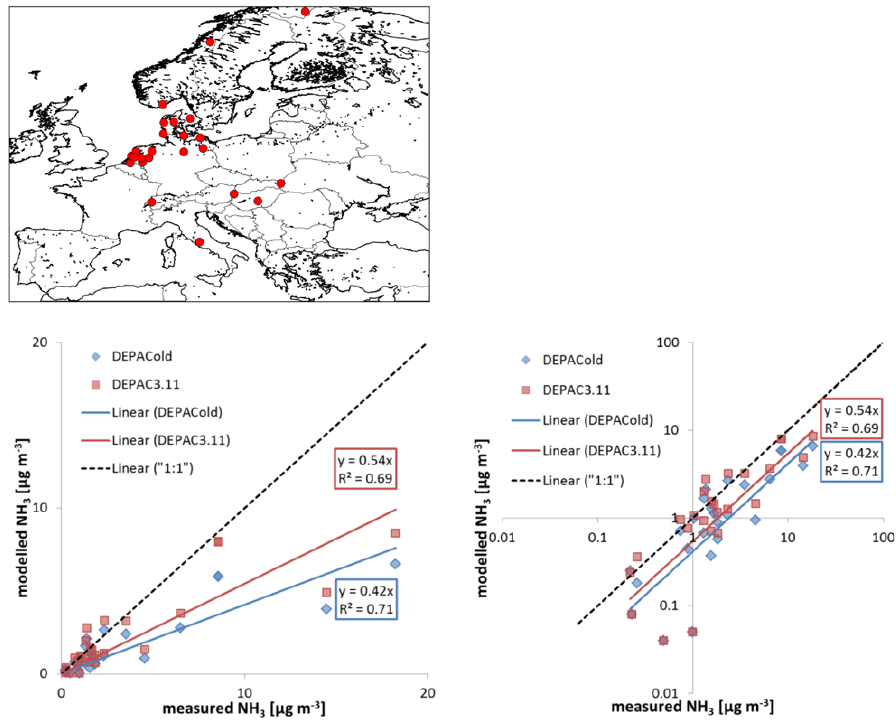
Fig. 7. Comparison of the modeled ammonia concentrations (with DEPACold and DEPAC3.11) with the measured concentrations at the available EMEP stations in Europe and the NAQMN in the Netherlands ( n = 24) in 2007. The grid resolution of the model results is 0.50 ◦ longitude × 0.25 ◦ latitude ( ∼ 28 × 28km 2 ) . The upper figure shows the locations of the measurement stations; the lower left figure shows the comparison on a normal scale; the lower right figure shows the comparison on a log-log scale.